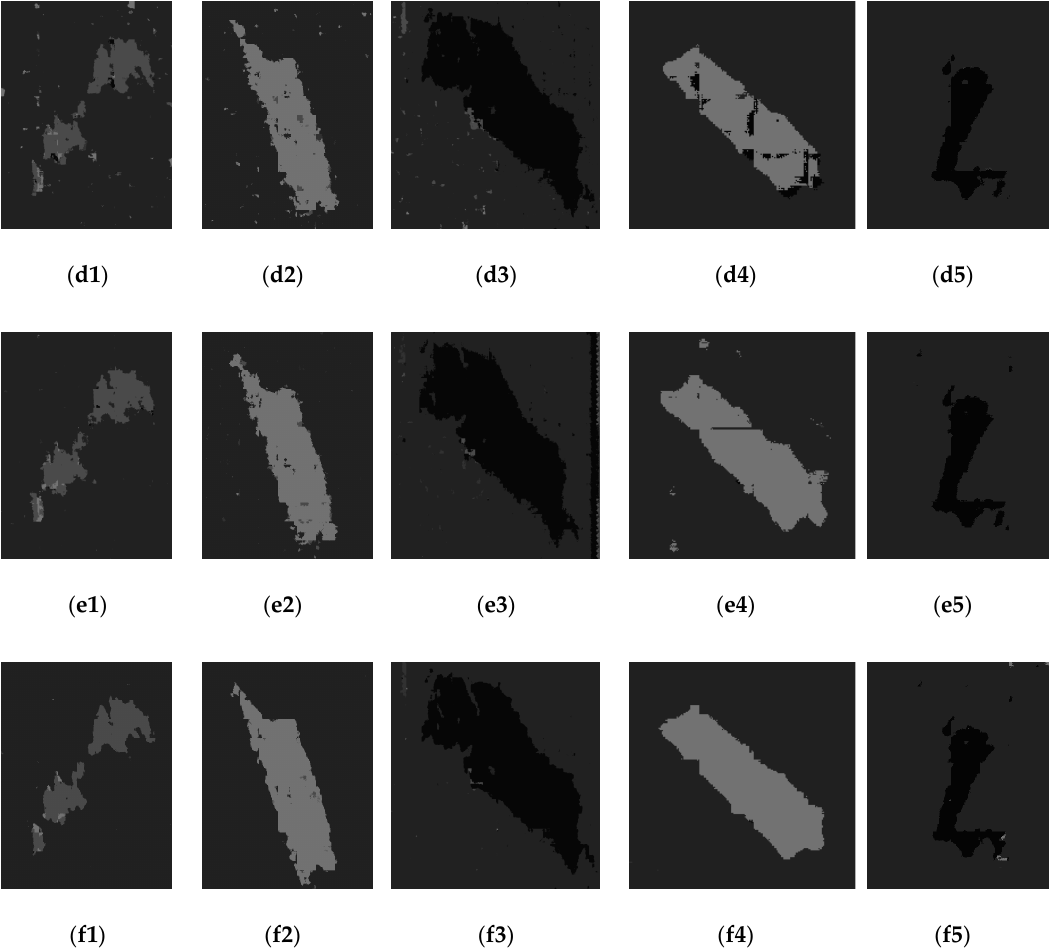
Figure 10. The results of dark spots area verified by polarized parameters combined with SLIC superpixel segmentation, 1-3 in each group represents emulsion, 2 for biogenic look-alike, 3 for oil-spill area of Image 1. Images 4 and 5 represent biogenic look-alike and oil spill area of Image 2 and Image 3. ( a1 – a5 ) Ground truth, ( b1 – b5 ) H / A / Alpha, ( c1 – c5 ) H / A / SERD / Alpha, ( d1 – d5 ) Scattering Coe ffi cients,